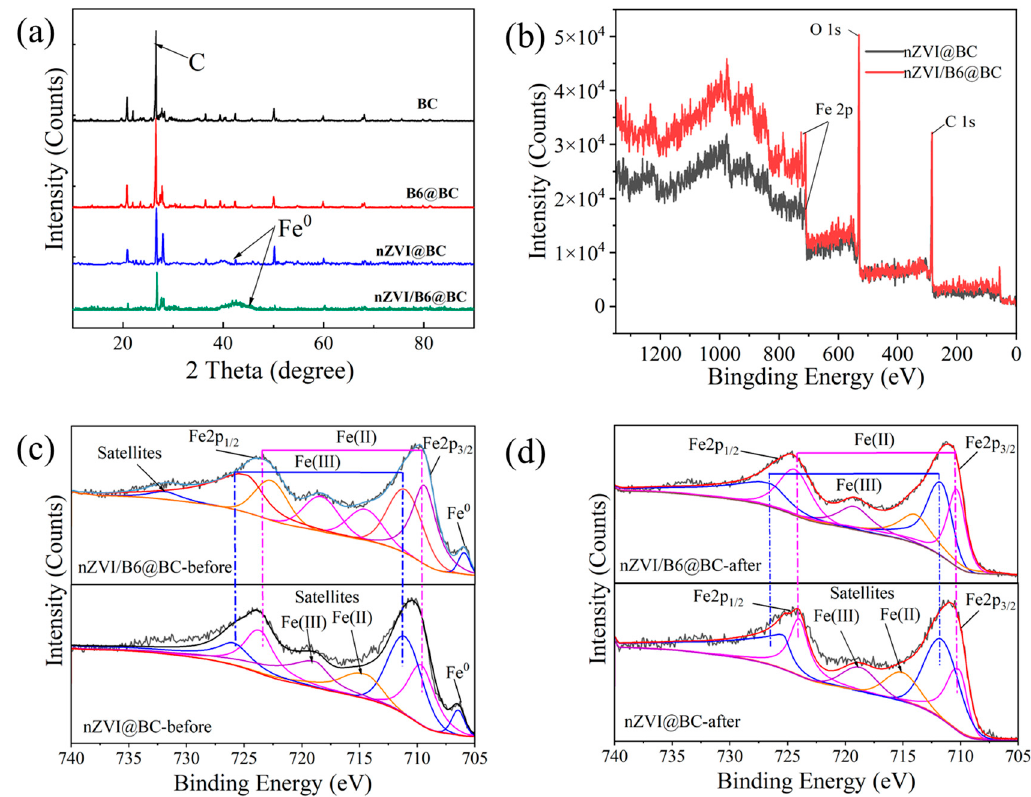
Figure 4. X-ray analyses of biochar materials ( a ) XRD, ( b ) XPS, ( c ) high-resolution Fe spectra